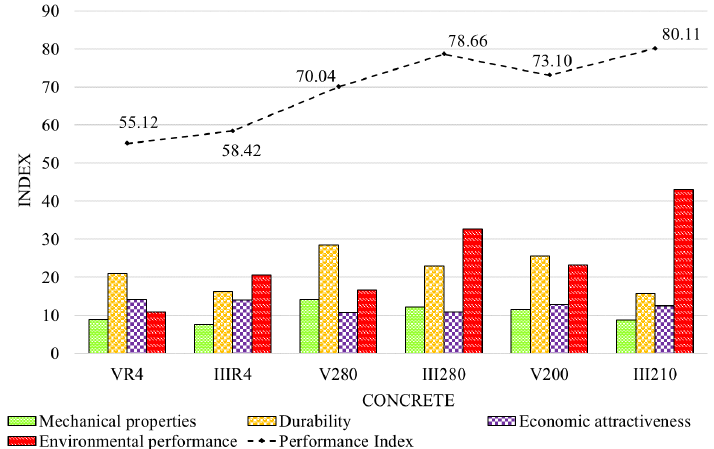
Figure 5. Partial indices of criteria and final performance index - Scenario 3 (foundation